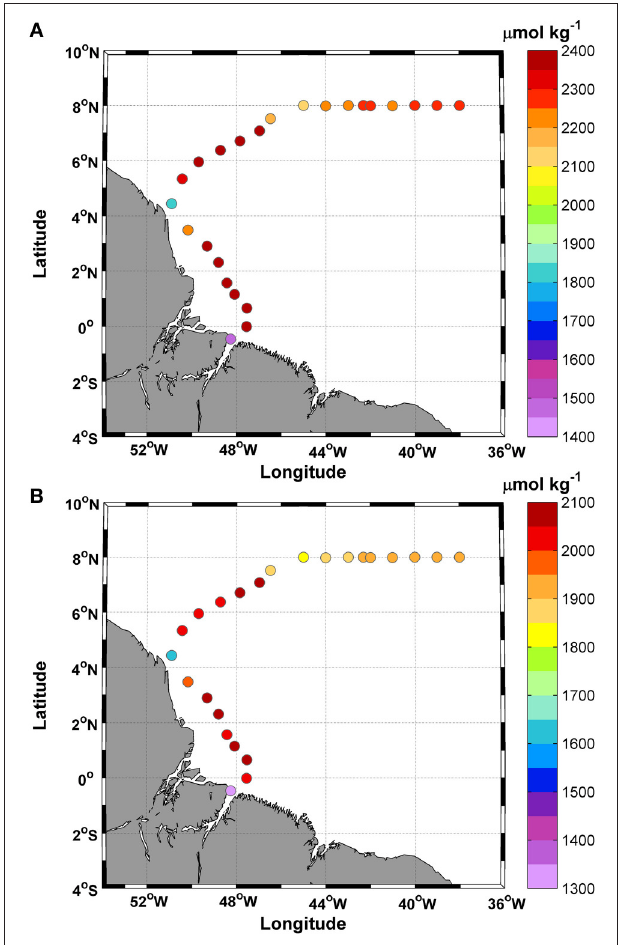
FIGURE 5 | Distributions of (A) Total alkalinity (TA); and (B) Dissolved inorganic carbon (DIC), along the ship track during the CF3 cruise, October 2012.